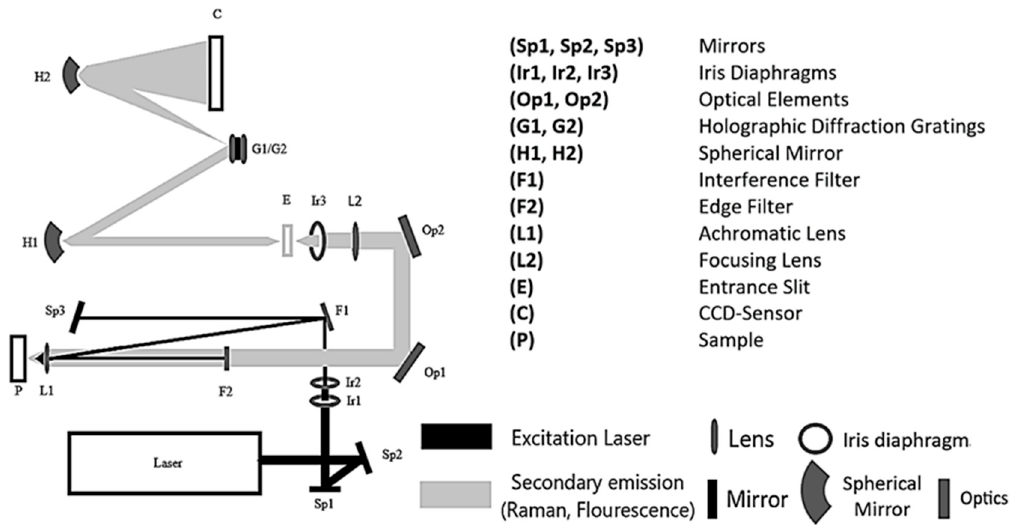
Figure 1. Optical set-up of the DUV Raman PL 200 from Photon Systems. The monochromatic light of the NeCu laser is focused by two mirrors (Sp1, Sp2) to get through two iris diaphragms (Ib1, Ib2), which regulate the aperture and the light intensity. The beam passes through an interference filter (F1), coated with a dielectric material, allowing the reflection of only the laser excitation wavelength of λ = 248.6 nm. After that, the light is directed to a third mirror (Sp3) and then thrown back onto the interference filter (F1). The laser beam gets reflected at a different angle onto the achromatic objective (L1), which focuses the beam onto the measuring cuvette or the sample (P). The scattered Raman radiation passes through the achromatic objective (L1) and a lens (F2), which correspond to an edge filter. The Raman radiation is guided through the entrance slit (E) via two optical elements (Op1, Op2), a focusing lens (L2), and an iris diaphragm (Ib3) to finally hit the two spherical mirrors (H1, H2). The Raman radiation gets scattered onto one of the two holographic diffraction gratings (G1, G2) to be detected by the CCD sensor